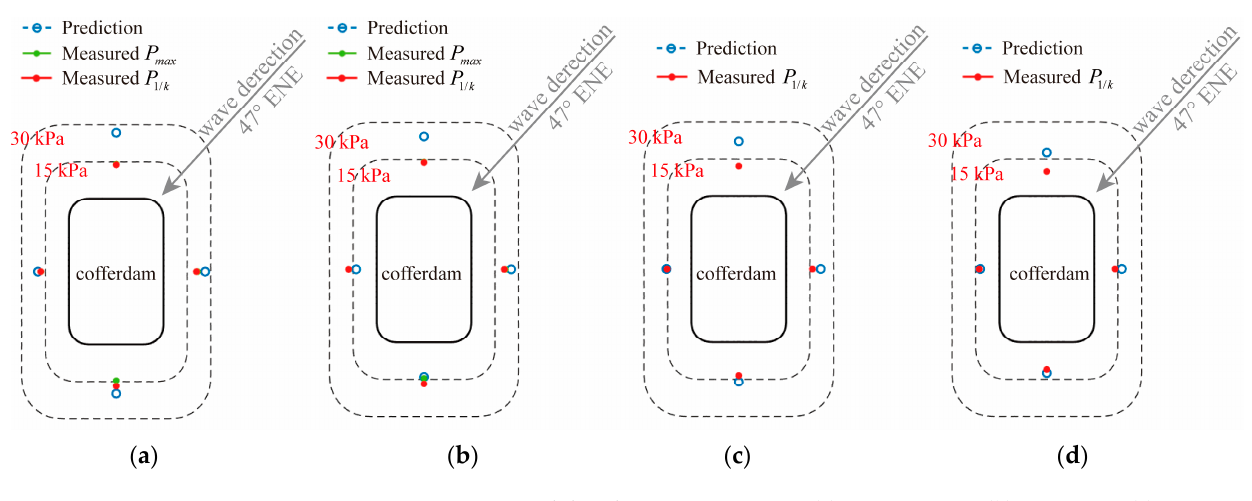
Figure 12. Pressure spatial distributions at − 6.37 m. ( a ) H 1/100 , T 1/100 ( b ) H 1/100 , T m ( c ) H 1/10 , T 1/10 ( d ) H 1/3 , T 1/3